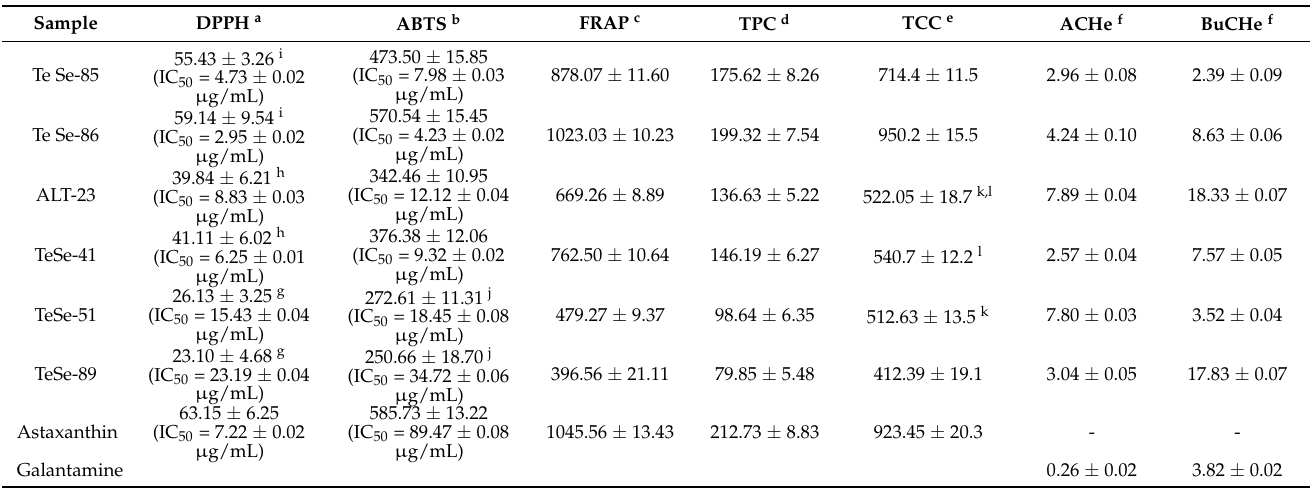
Table 2. Scavenging of the 1,1-diphenyl-2-picrylhydrazyl radical (DPPH), radical ABTS, (ABTS), total phenolic content (TPC), total carotenoid content (TCC) and cholinesterase inhibition capacity of six haloarchaea (Te Se-85, Te Se-86, ALT-23, TeSe-41, TeSe-51 and TeSe-89) from the II Region of Chile. ( n =